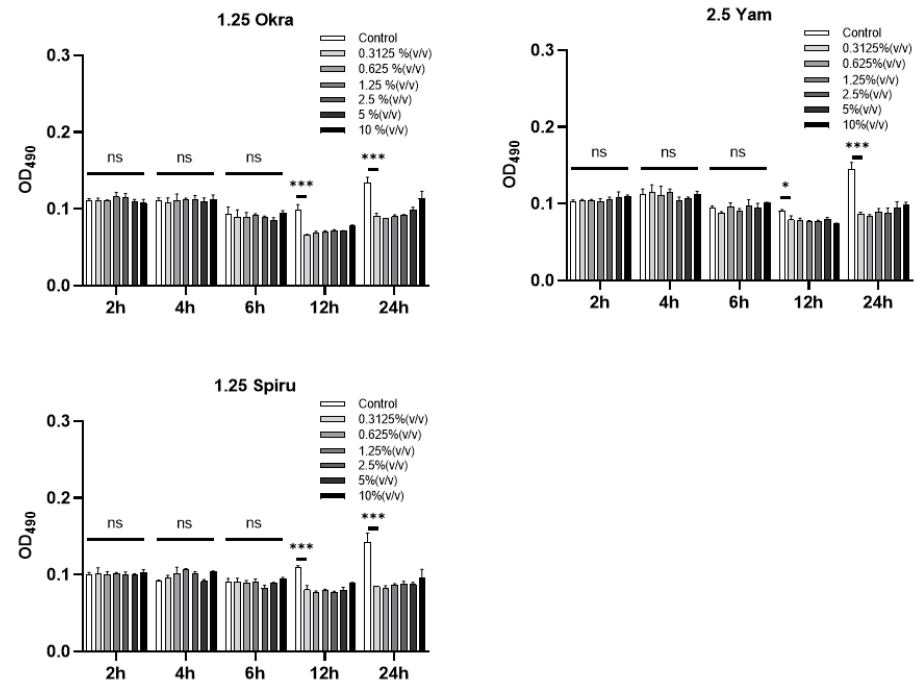
Figure 4. MTT assays of the three emulsions. Intestinal Caco-2 cells were cultured and six groups were set up: negative control and 10% ( v / v ), 5% ( v / v ), 2.5% ( v / v ), 1.25% ( v / v ), 0.625% ( v / v ), and 0.3125% ( v / v ) W 1 /O/W 2 emulsions. The absorbance was read at OD = 490 nm. * p < 0.05; *** p < 0.001; ns, no significance.